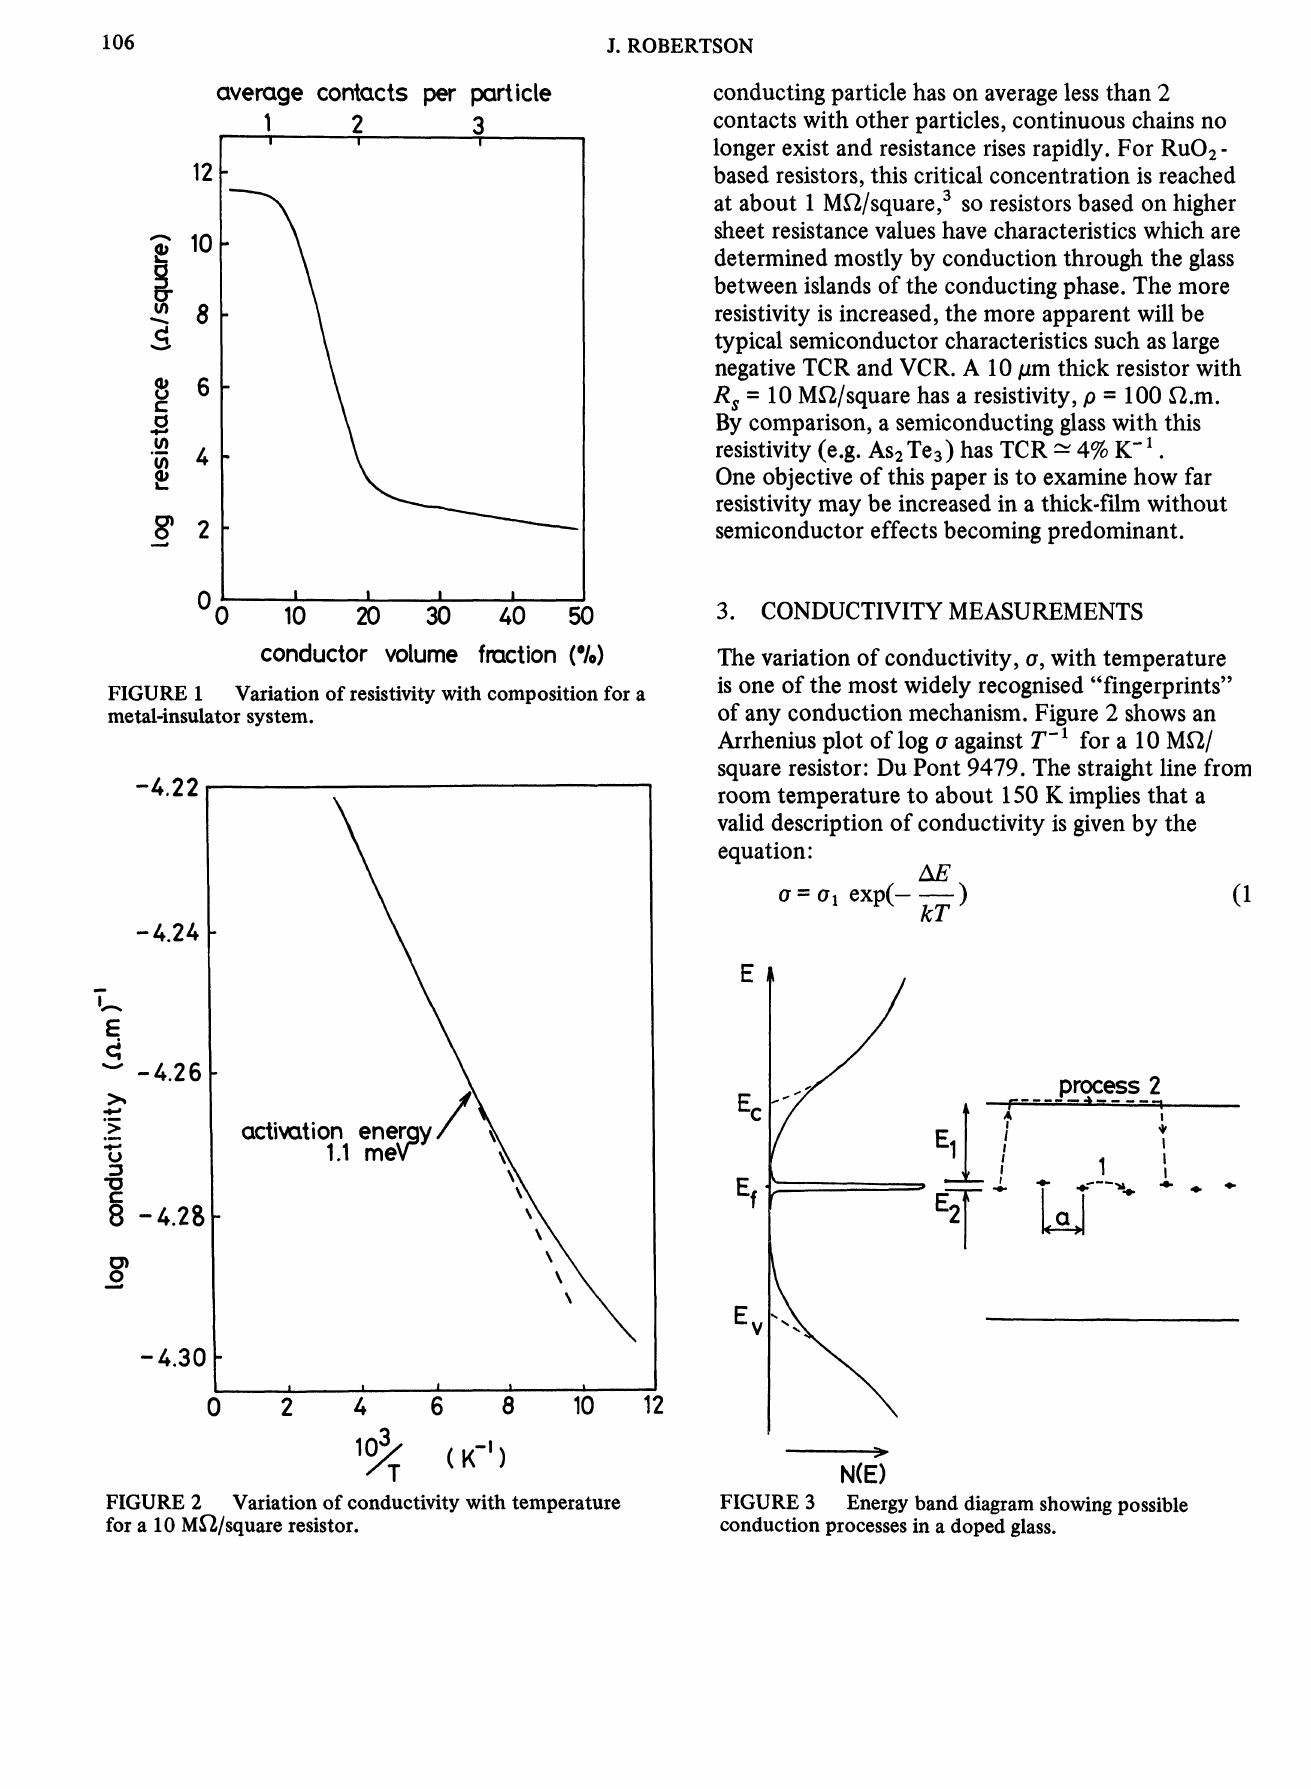
FIGURE 2 Variation of conductivity with temperature for a 10 M/square resistor.